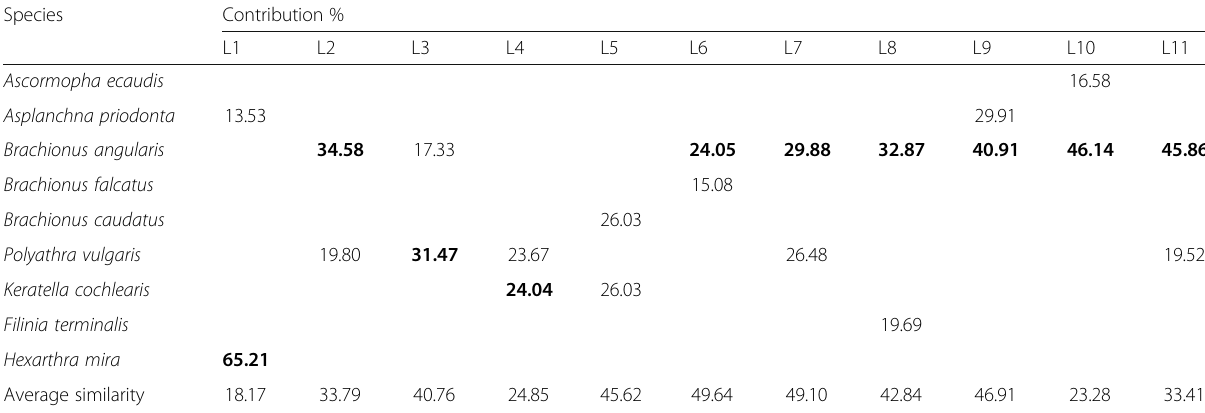
Table 4 Major rotifer contribution to the average similarity determined by SIMPER analysis in studied lakes and ponds